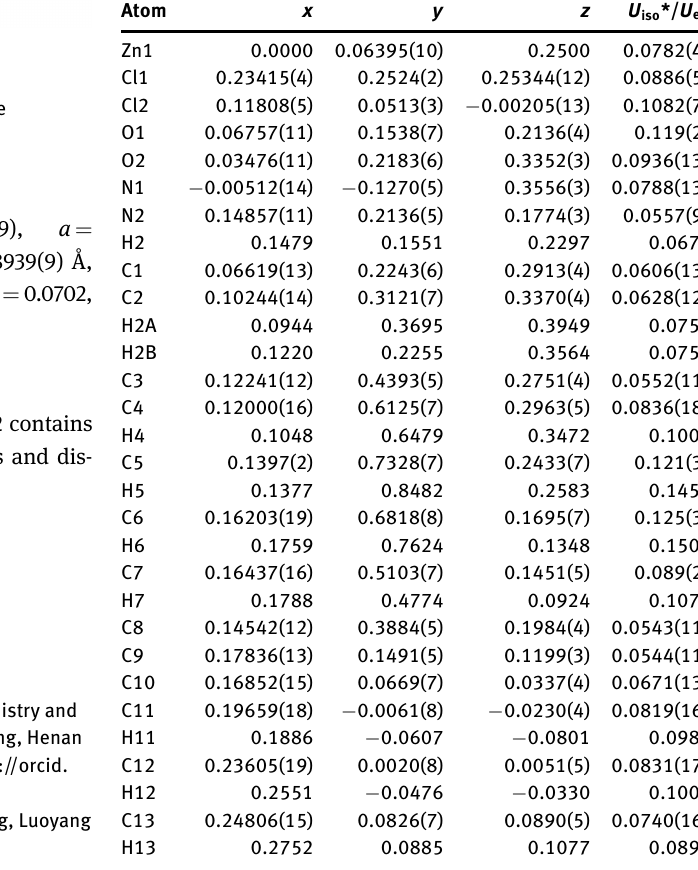
Table 2: Fractional atomic coordinates and isotropic or equivalent isotropic displacement parameters (Å 2